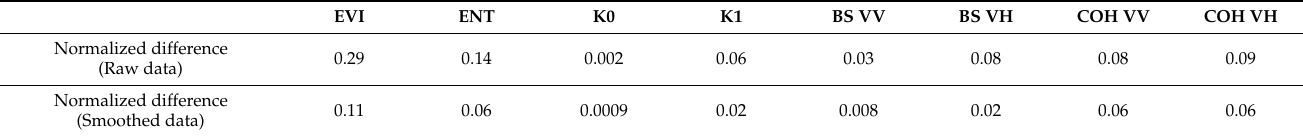
Table 1. Average absolute differences of six days before and six days after a mowing event for all mowing events (n = 45) of all 13 parametrization sites. The differences are normalized with the 95% percentile of each parameter of all values of the parametrization sites of raw and smoothed data, accordingly. EVI ENT K0 K1 BS VV BS VH COH VV COH VH Normalized difference (Raw data) 0.29 Normalized difference (Smoothed data) EVI = Enhanced vegetation index, ENT = PolSAR entropy, K0 = PolSAR K0, K1 = PolSAR K1, BS VV = Backscatter VV, BS VH = Backscatter VH, COH VV = InSAR coherence VV, COH VH = InSAR coherence